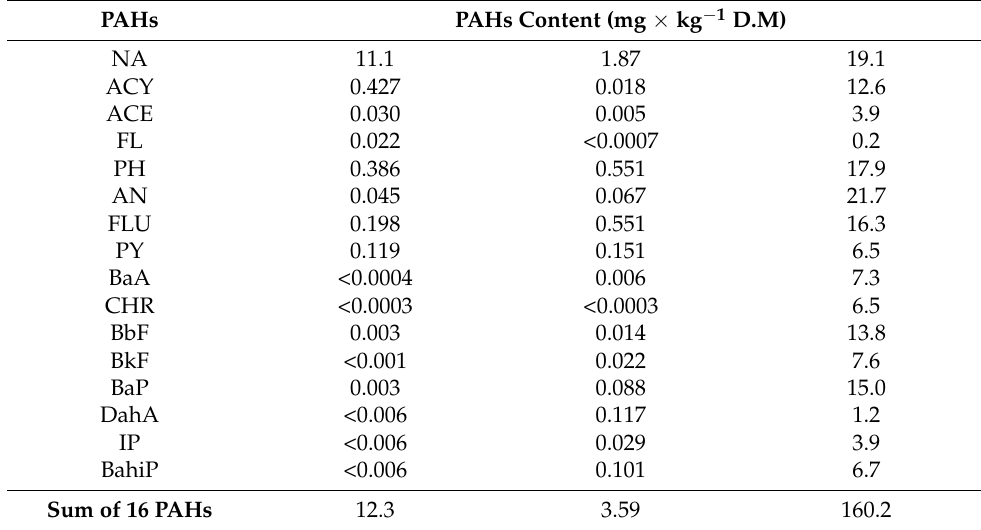
Table 3. Content of PAHs in fly ash from biomass combustion [29,32].